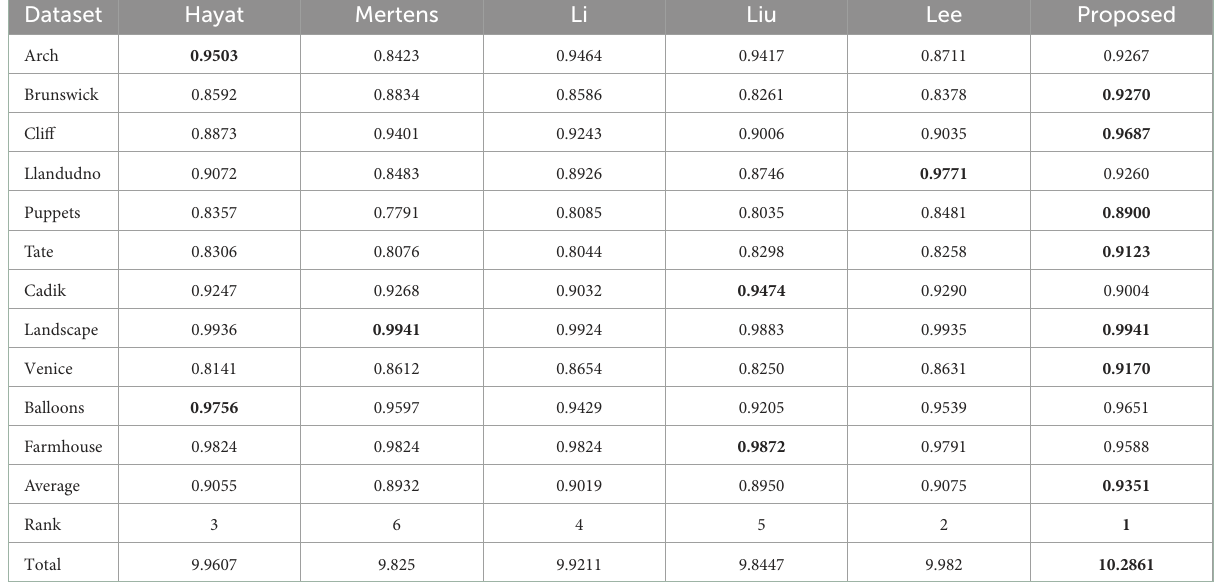
TABLE 1 MEF-SSIMd of six MEF methods.